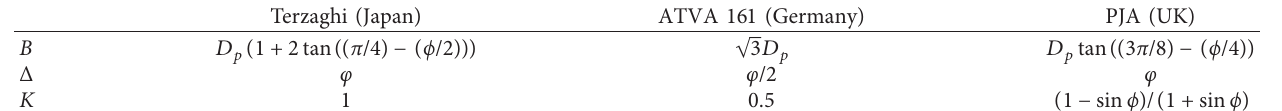
Table 2: Summary table of assumed model parameters.